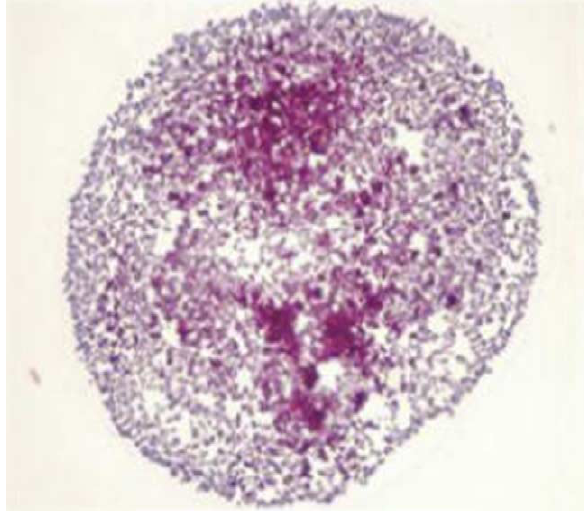
Fig. 10. CRL-2170 Human cell line after deposition onto the slide and stained with H&E Stain.